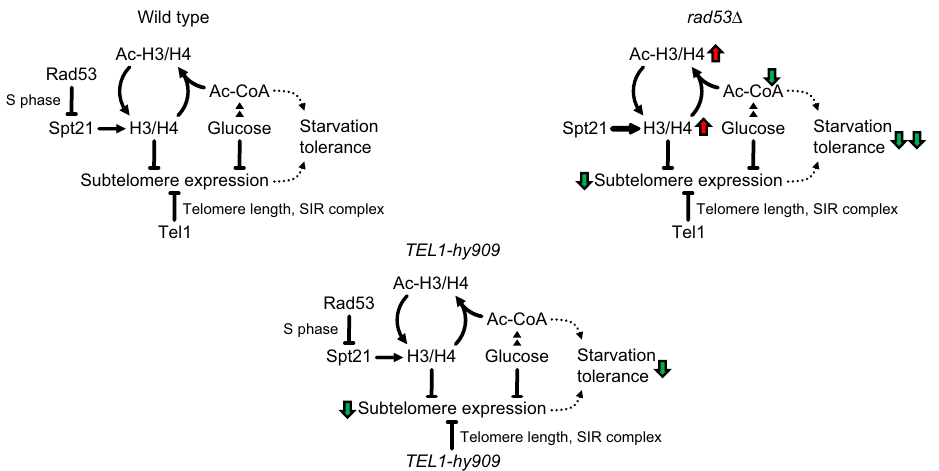
Fig. 7 Model. Rad53 regulates histone expression through inhibition of Spt21 NPAT by phosphorylation. Absence of this regulation causes accumulation of histones. Hyperacetylated excess histones reduce growth-limiting Ac-CoA-derived carbon metabolites. Excess histones also silence starvation-responsive subtelomeric genes. Hyper-acetylation and subtelomeric gene silencing reduce the glucose starvation tolerance of rad53 mutants. Hyperactive Tel1-hy909 increases telomere length and subtelomere silencing and thereby reduces glucose starvation tolerance in a histone-independent manner. Red and green arrows indicate the directions of